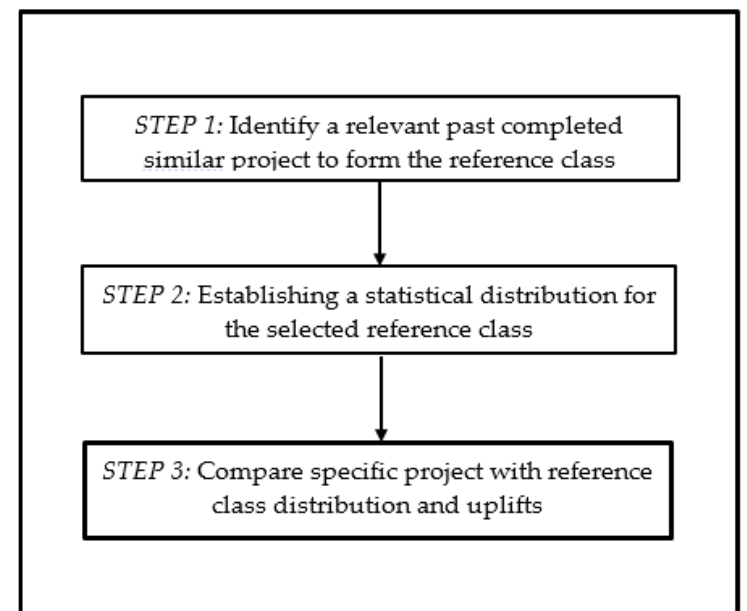
Figure 1. Steps for RCF based on the outside view [9].